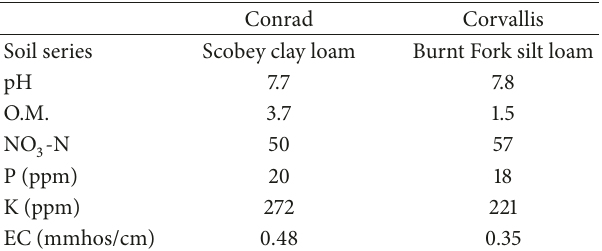
Table 1: Initial preplant soil test results (0–60cm), Conrad and Corvallis, 2011.